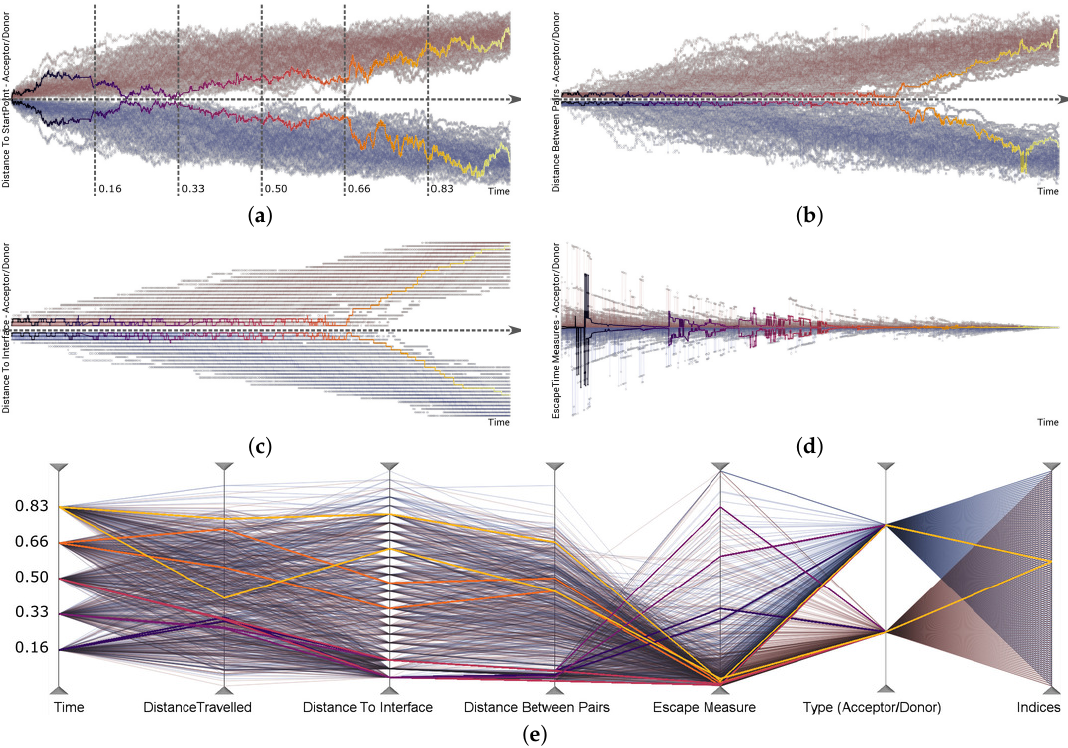
Figure 11. The plots of the derived measures for the ensemble highlighting one selected trajectory, the x -axis of all plots is time, which is also encoded in the color of the trajectories. The y -axis are ( a ) effective distance travelled from start point; ( b ) distance between the charge pairs; ( c ) shortest distance to the interface; ( d ) escape time for a radius of 10 units; ( e ) parallel coordinates of all the measures ( a ) through ( e